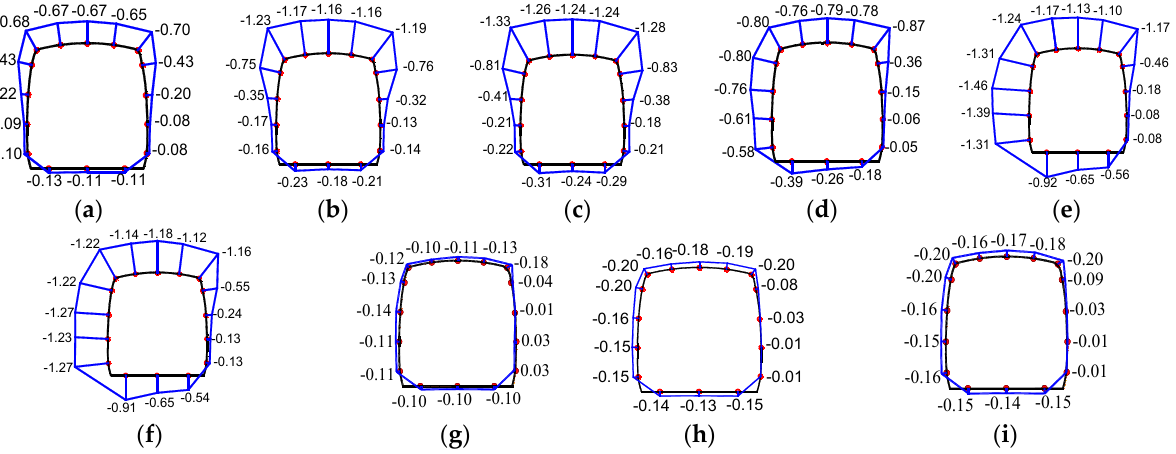
Figure 13. Mean pressure coefficients at the middle section for three different swirl ratios ( λ = 0). ( a ) S = 0.15, R / R c = 0; ( b ) S = 0.35, R / R c = 0; ( c ) S = 0.72, R / R c = 0; ( d ) S = 0.15, R / R c = 1.5; ( e ) S = 0.35, R / R c = 1.5; ( f ) S = 0.72, R / R c = 1.5; ( g ) S = 0.15, R / R c = 3.75; ( h ) S = 0.35, R / R c = 3.75; ( i ) S = 0.72, R / R c = 3.75.